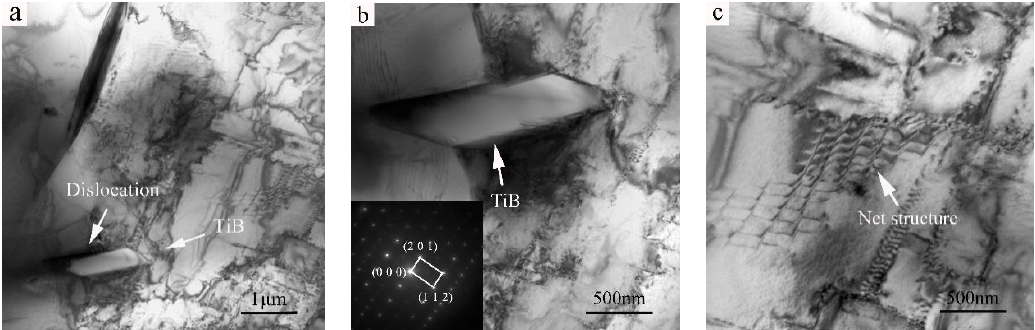
Figure 7. TEM images of Ti-7Al-0.2B, ( a ) Dislocation, ( b ) TiB particle and selected area electron microscopy (diffraction pattern), ( c ) Net structure.